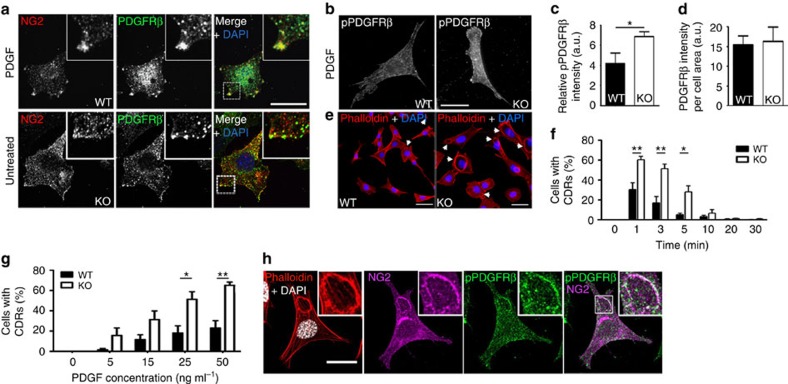
Increased PDGFR activation and circular dorsal ruffle formation in Stonin1−/− MEFs.(a) NG2 clusters contain PDGFRβ. Confocal images of WT and Stonin1−/− MEFs untreated or incubated with PDGF as in Fig. 6 and immunolabelled with antibodies against NG2 and PDGFRβ. Scale bar, 25 μm. (b–d) Increased levels of activated PDGFRβ in Stonin1−/− MEFs, while total levels are unchanged. (b) Epifluorescent images of WT and Stonin1−/− MEFs incubated with 50 ng ml−1 PDGF for 3 min and immunolabelled with antibodies against activated PDGFRβ (pPDGFR). Scale bar, 50 μm. (c) Quantification of relative fluorescence intensity of pPDGFRβ from images such as in b (N=5). (d) Quantification of relative fluorescence intensity of total PDGFRβ from images of WT and Stonin1−/− MEFs immunolabelled with PDGFRβ-specific antibodies (N=3). (e–f) Stonin1−/− MEFs have more CDRs upon PDGF treatment. (e) Example epifluorescent images of WT and Stonin1−/− MEFs treated for 3 min with 50 ng ml−1 PDGF and immunostained with fluorescently labelled Phalloidin to visualize F-actin. Arrows point to CDRs. Scale bar, 25 μm. (f) Quantification of the percentage of cells with CDRs from images as in e after different incubation times with 50 ng ml−1 PDGF. (g) Stonin1−/− MEFs need a lower PDGF concentration to trigger CDR formation. WT and Stonin1−/− MEFs were treated for 3 min with the indicated concentrations of PDGF and immunostained with fluorescently labelled Phalloidin to visualize F-actin. The number of cells containing CDRs was quantified for each condition. (h) NG2 localizes to CDRs. Confocal image of NG2-transfected MEF incubated with 50 ng ml−1 PDGF for 5 min and immunolabelled with antibodies against NG2 and pPDGFRβ. Actin was visualized by fluorescently labelled phalloidin. Nuclei were stained with 4,6-diamidino-2-phenylindole (DAPI). Scale bar, 25 μm. All data are depicted as mean±s.e.m. and compared by unpaired two-tailed Student's t-tests, **P<0.01, *P<0.05.